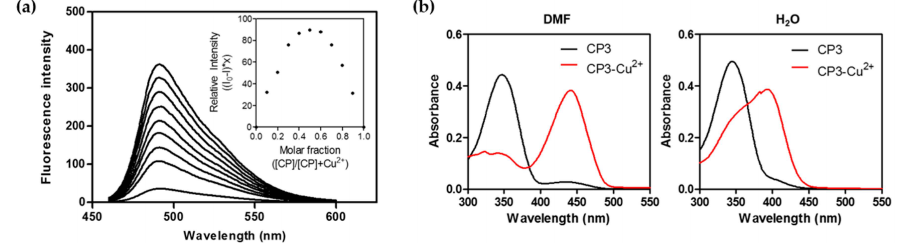
Figure 4. Spectroscopic features of CP3 in the presence of Cu 2+ . ( a ) Job plot data on emission changes upon addition of Cu 2+ in DMF at 492 nm ( λ ex = 441 nm). The X-axis represents the molar fraction of CP3 and the Y-axis represents relative fluorescence intensity at an invariant total concentration of 1 µ M; ( b ) UV-Vis spectra of CP3 (50 µ M) and CP3 -Cu 2+ (50 µ M) in DMF and H 2